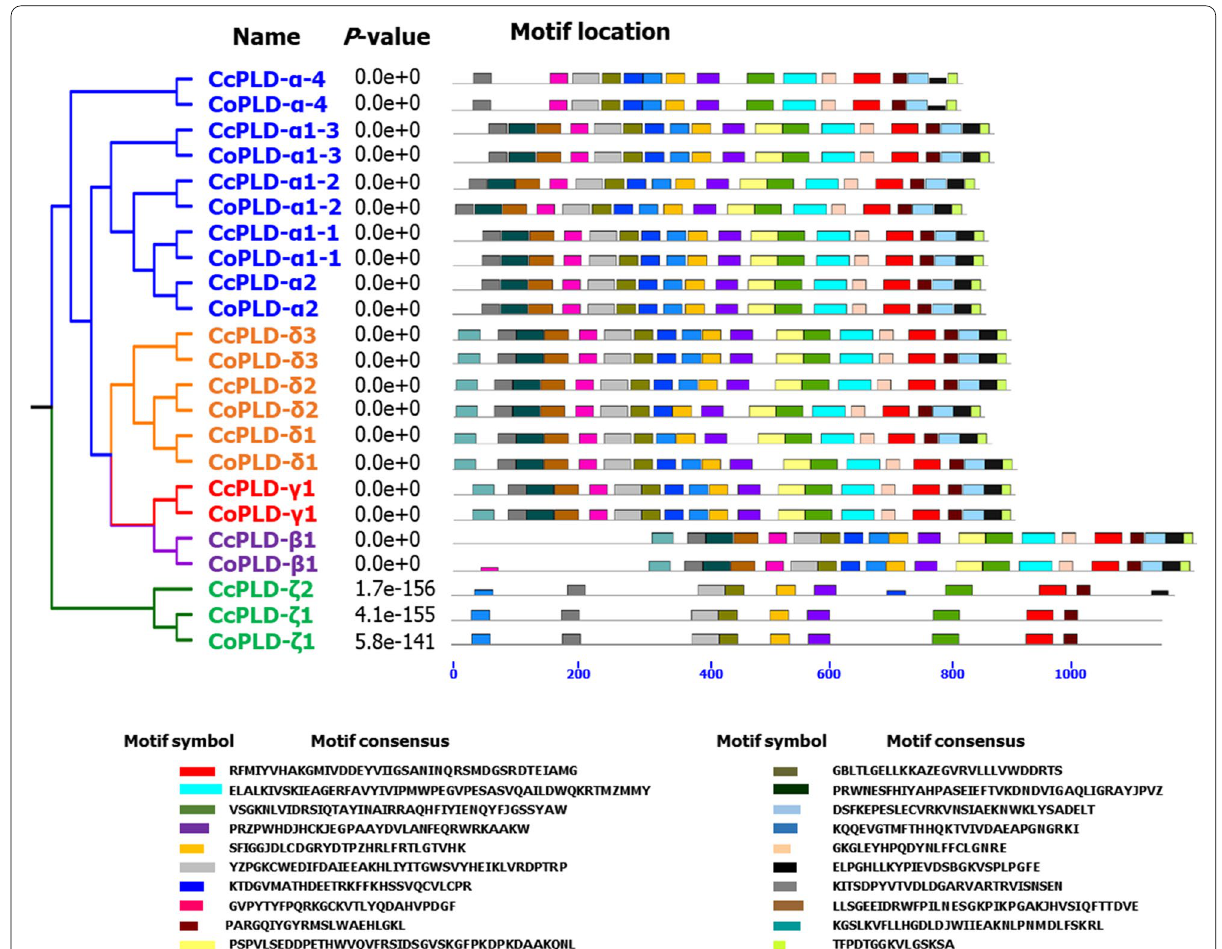
Fig. 3 CcPLD and CoPLD genes and motifs structure. Exons and introns are indicated by boxes and lines, respectively. Motifs are numbered from 1 to 20 and highlighted in different colors. The length of motif for each PLD genes are displayed proportionately. The dendrogram in the left-hand side indicated four distinct phylogenetic